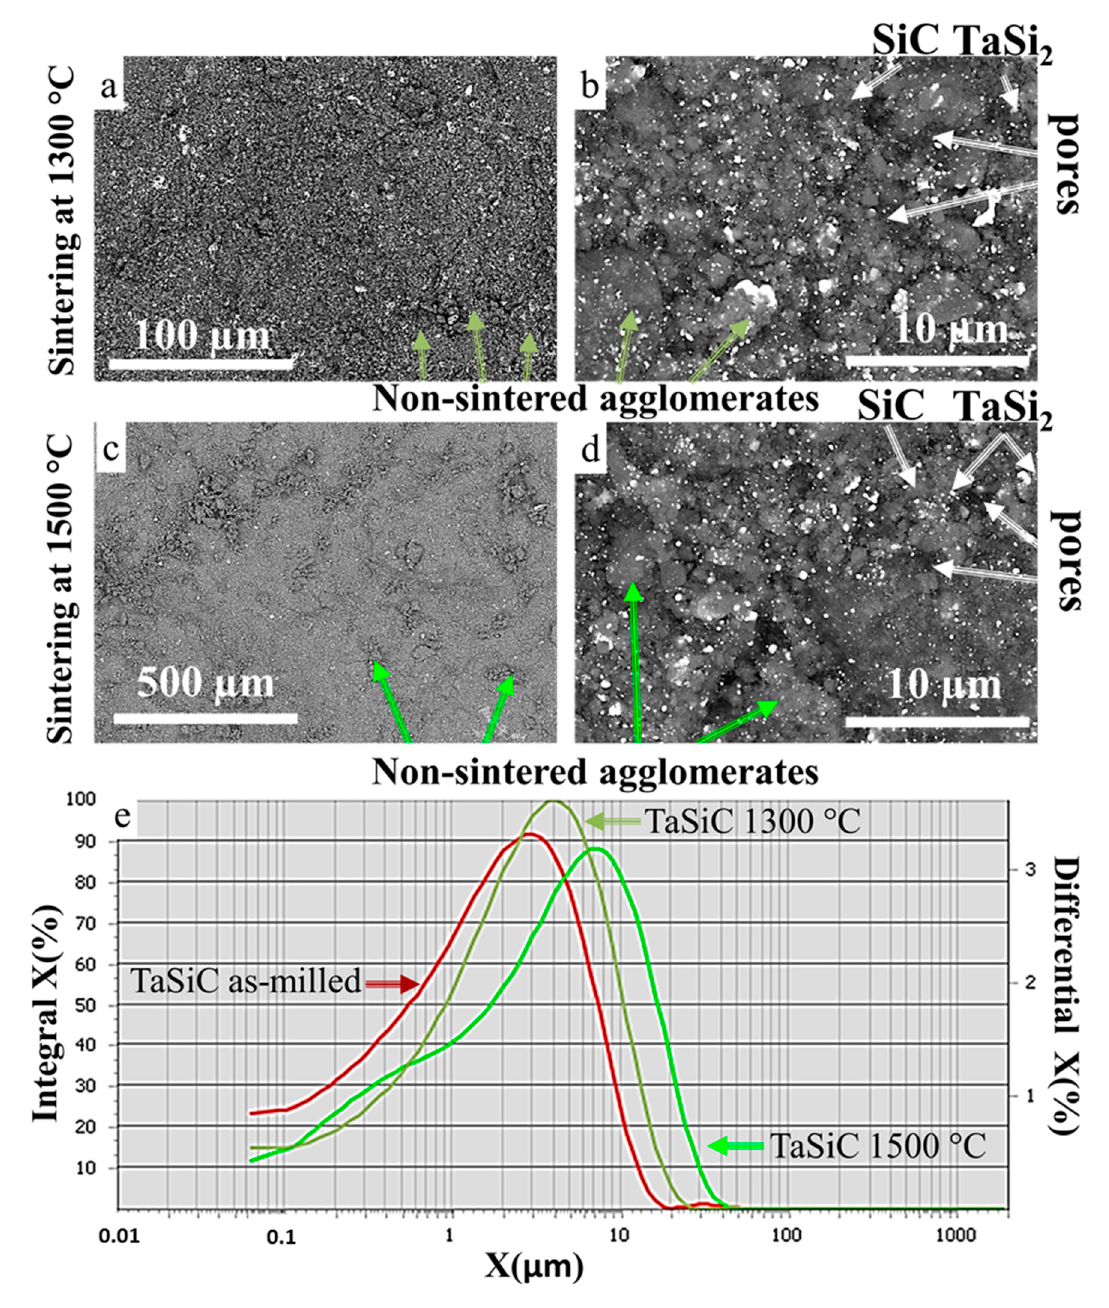
Figure 3. SEM images of TaSiC powders. ( a , b ) Sintered at 1300 °C; ( c , d ) Sintered at 1500 °C; ( e ) Histograms with the agglomerate size in the TaSiC samples before sintering and after sintering at 1300 and 1500 °C.